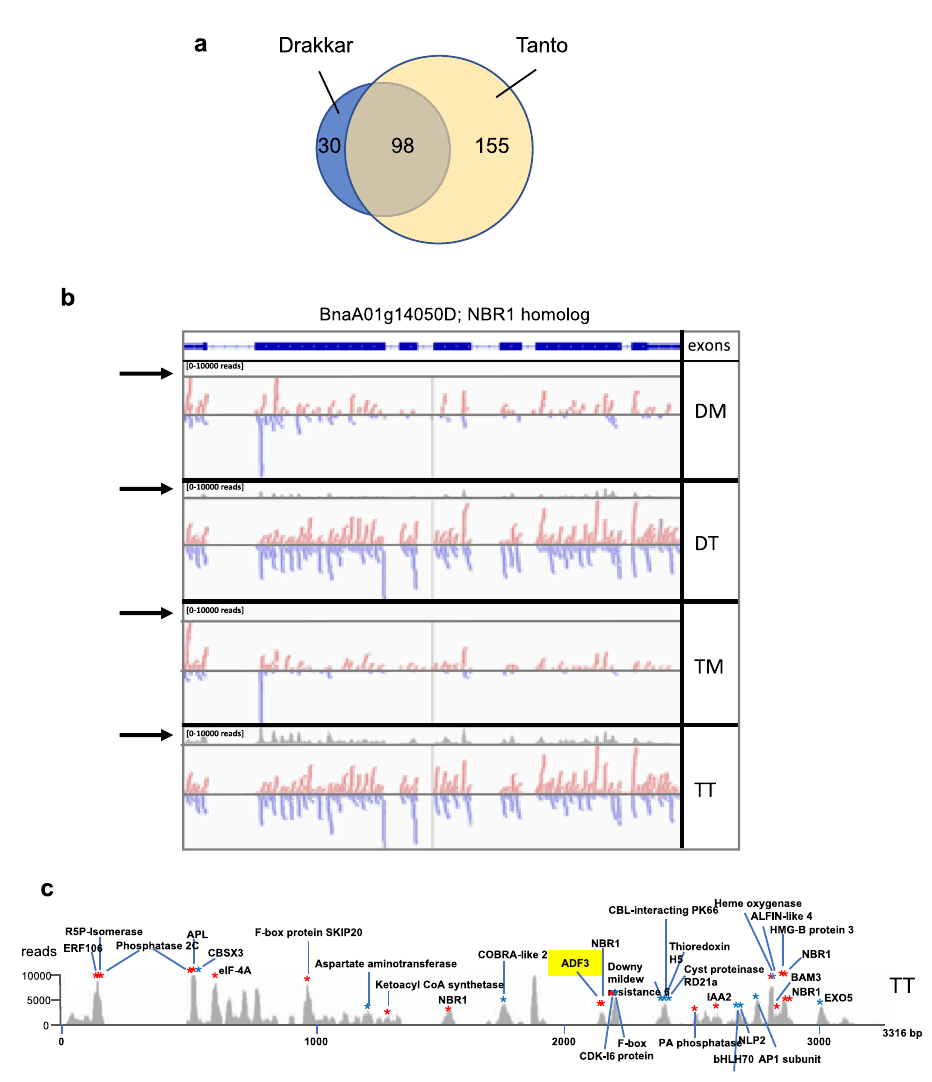
Fig. 4 Infection induces the production of host-encoded vasiRNAs with potential to target other host genes. a Number of vasiRNA-producing loci in Drakkar and Tanto. b vasiRNAs produced by the NBR1 gene (BnaA01g14050D). Unique vasiRNAs sequenced in DM, DT, TM, and TT samples align along the exonic regions of the gene transcript. Arrows indicate diagrams showing the abundance of the vasiRNAs aligned to the transcript (scale: 0 – 10000 reads). c Trans -acting vasiRNAs derived from NBR1 . vasiRNAs associated with mRNA target cleavage signatures are derived from the peaks of vasiRNA production. The vasiRNA peaks from infected Tanto (TT) samples are shown (peaks in the DT sample are similar, but not as high). Red and blue dots indicate vasiRNAs derived from the positive and negative strands of the NBR1 double-stranded RNA, respectively. A peak of vasiRNAs that target transcripts from ADF3 is highlighted in degradome data for virus-speci fi c signatures derived from the (Supplementary Data 14 and Fig. 5). Among them, 29 target ( + ) and ( − ) vRNA strands. Several of the virus-speci fi c sig- pairs were found in both Drakkar and Tanto. 5 ′ -Degradome natures could be associated with vsiRNA-vRNA target pairs. signatures were particularly abundant at nucleotide positions These revealed 56 unique vsiRNAs derived from the negative 9868 and 10,231 (referred to as A and B) in both cultivars, strand of the virus as plausible guides for cleavage of vRNA suggesting that they represent prominent cleavage sites within